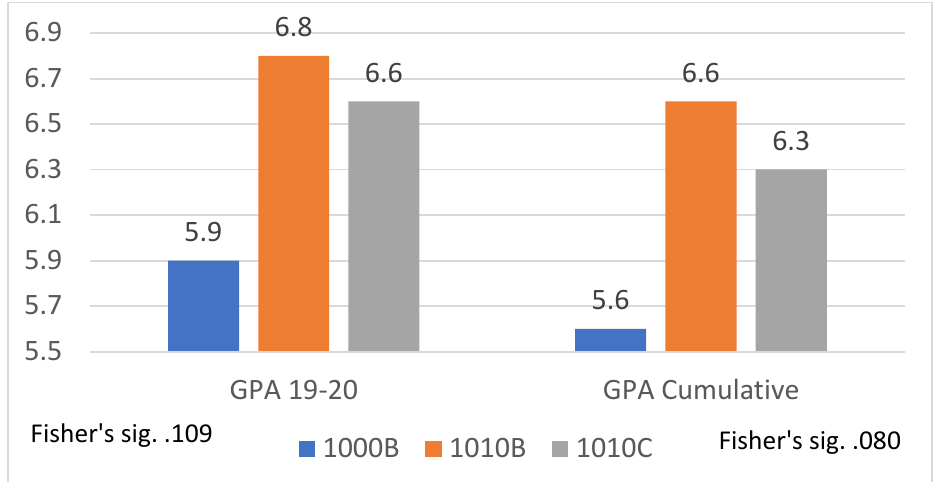
FIGURE 5. OVERALL GPA 19-20 BY